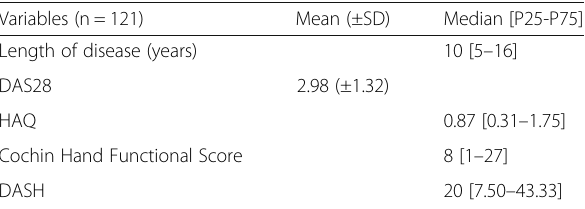
Table 3 Length and activity of disease and functional ability of participants in the rheumatoid arthritis group (RAG) Variables (n = 121)